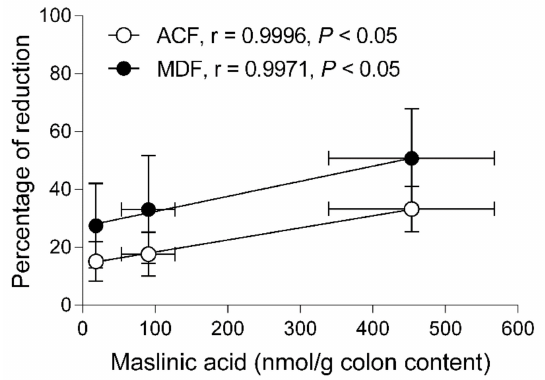
Figure 8. Pearson correlations of the reductions of aberrant crypt foci (ACF) and mucin depleted foci (MDF) versus concentrations of maslinic acid in the colonic content. Values are represented as means ± SEM. Horizontal bars are the SEM of the concentrations of maslinic acid in the colon ( n = 6 for each dose). Vertical bars represent the SEM of the percentage of reduction of ACF ( n = 6 for each dose) or MDF ( n = 6 for each